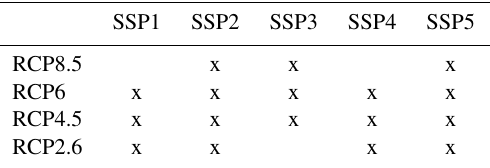
Table 2. Combination of RCP scenarios with SSP-basic-elements country results considered in this